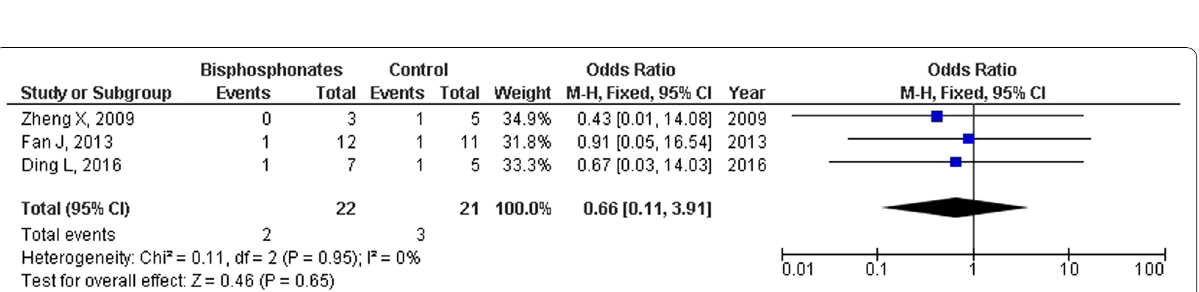
Fig. 6 The forest plot showing how bisphosphonates affect postoperative recurrence outcomes in patients with giant cell tumors of the bone after extensive excision as compared to a control